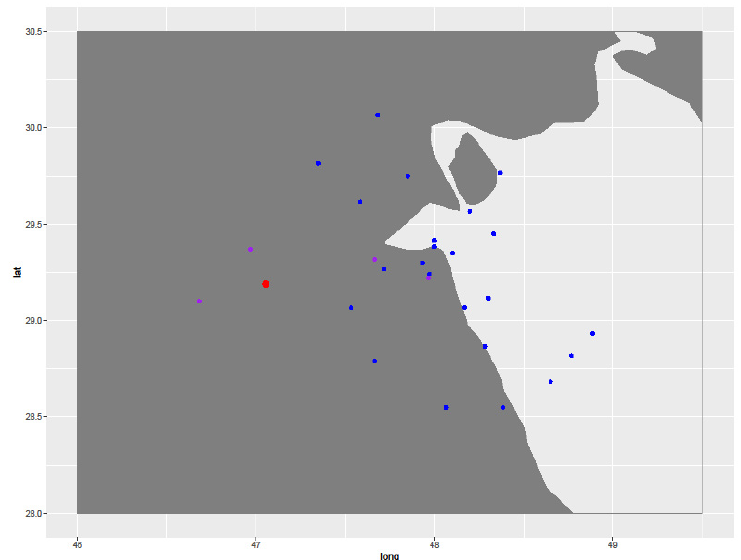
Figure 1. Location of ground-based observation stations in Kuwait: WMO Daily stations ( blue ); Integrated Surface Data stations ( purple ), Shagaya Renewable Energy Plant ( red ).